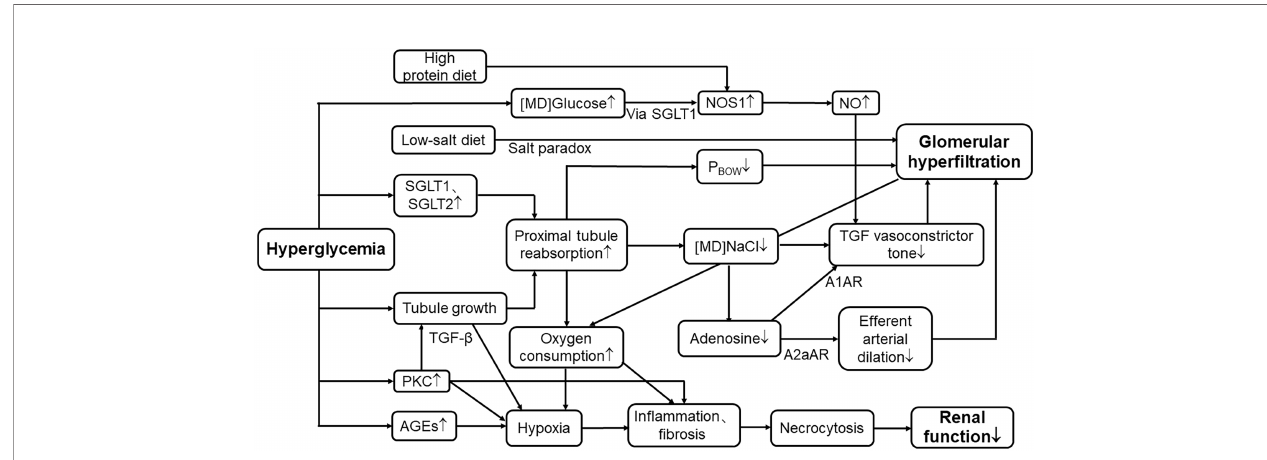
FIGURE 2 | Mechanisms of hyperglycemia in renal tubular events leading to hyper fi ltration and progression of nephropathy. SGLT1, sodium – glucose cotransporter1; SGLT2, sodium – glucose cotransporter2; [MD]NaCl, the concentration of sodium chloride in macula densa; TGF, tubuloglomerular feedback; P BOW , hydraulic pressure in Bowman ’ s space; [MD]Glucose, the concentration of glucose in macula densa; NOS1, nitric oxide synthase1; NO, nitric oxide; A1AR, A1 adenosine receptor; A2aAR, A2 adenosine receptor; PKC, protein kinase C; AGE, advanced glycation end products; TGF- b , transforming growth factor- b ; ↑ , elevate or increase; ↓ , decrease or